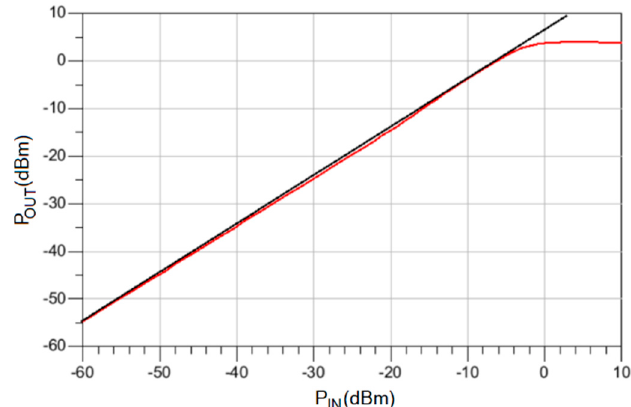
Figure 7. Simulated output power (red line) as a function of the input power to calculate the 1-dB compression point. The black line represents the ideal response without distortion.